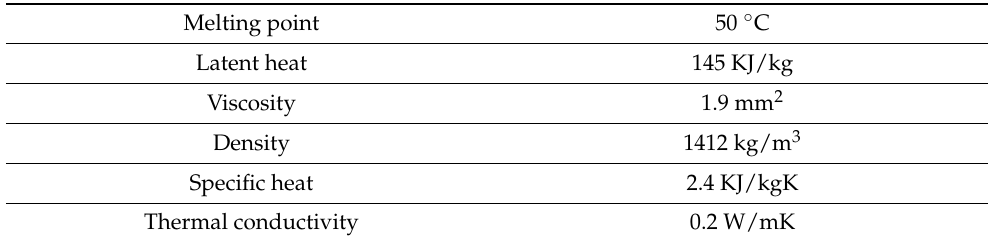
Table 2. The PCM’s thermo-physical properties.